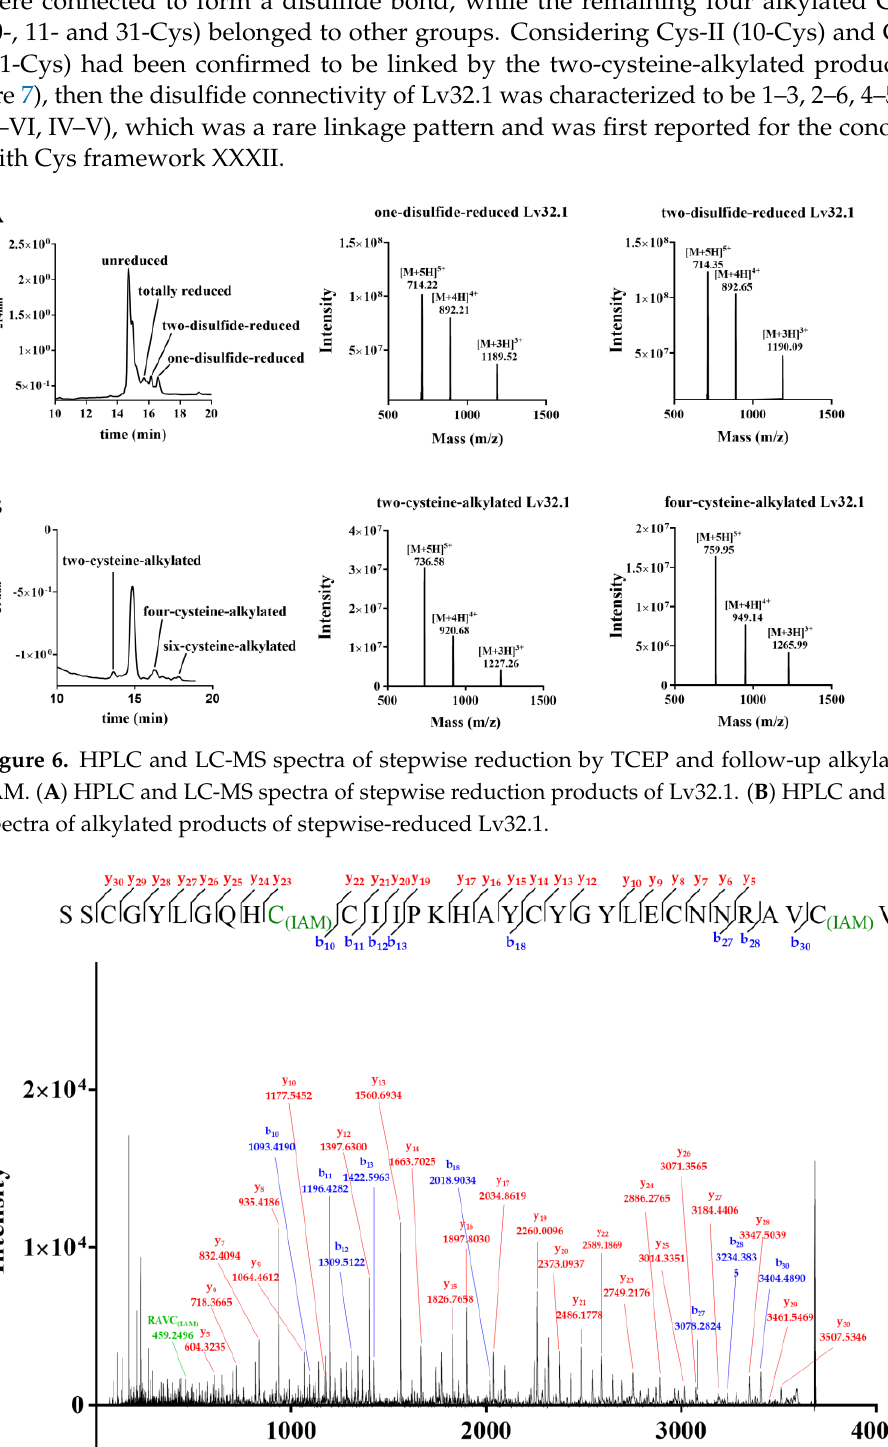
Figure 8. MALDI-TOF-MS/MS spectrum of four-cysteine-alkylated product of Lv32.1. C (IAM) repre- sented the ethyl-labeled cysteine by IAM. 2.3. Lv32.1 Exhibited Analgesic Potency To further explore whether conotoxin Lv32.1 has an analgesic effect, we used a hot plate assay to detect the latent value of mice at different time points after the intracerebro- ventricular ( i.c.v. ) administration of Lv32.1 (10 nmol per mouse). The behavioral manifes- tation in the hot plate test showed an evident increase in the pain threshold with time. Figure 9 suggested that the analgesic effect of Lv32.1 began to appear at 60 min and it had